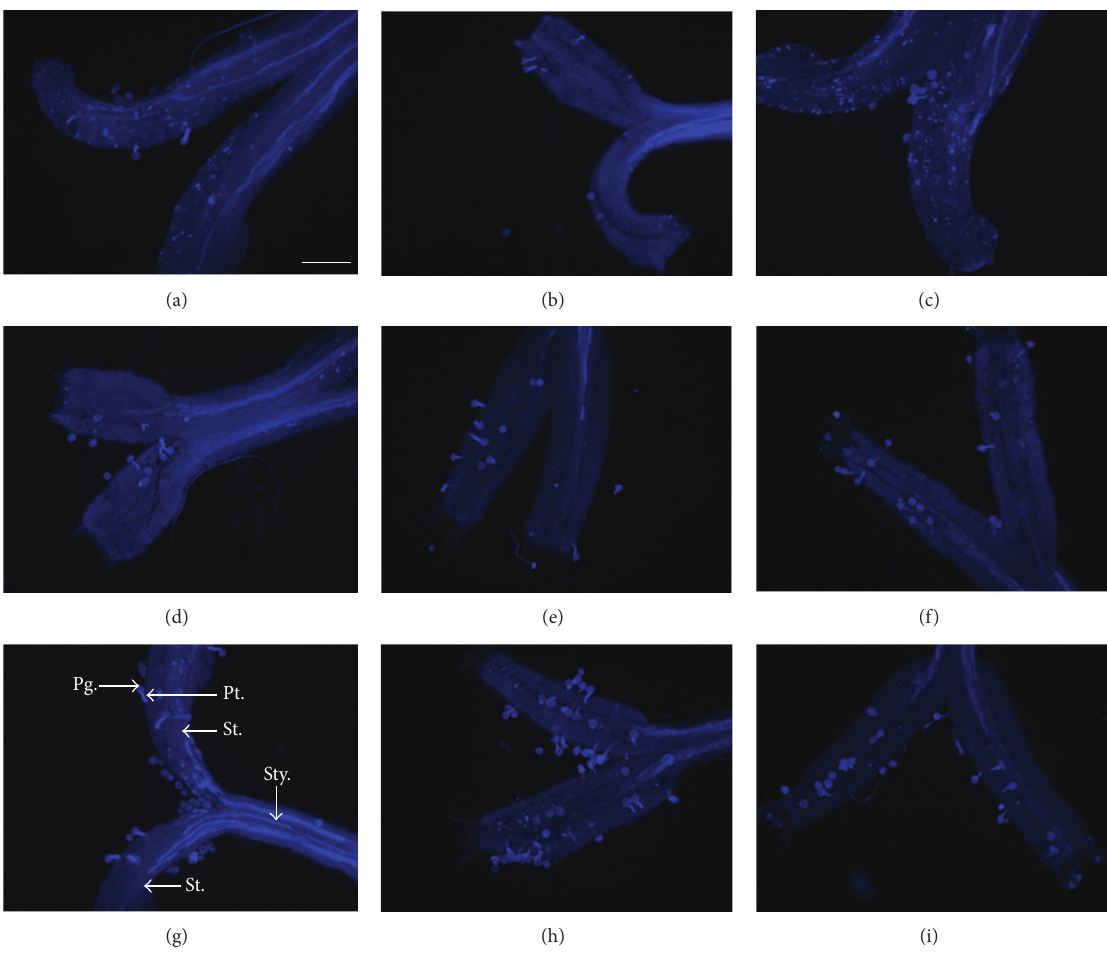
Figure 1: Germination behaviour of pollen grains on chrysanthemum stigmas at 24 hours after self-pollination. ((a), (b), and (c)) Three representativecultivars(“QX-081,”“Nannonghonghe,”“QX-0062f-3,”and“Nannongxiangbin”)withlownumberofpollengrainsgerminating onperstigma.((d),(e),and(f))Threerepresentativecultivars(“Nannongxiangbin”,“Q10-6-9,”and“Q10-17-3”)withmediumnumberofpollen grains germinating on per stigma. ((g), (h), and (i)). Three representative cultivars (“QX-097,” “Q10-33-1,” and “QX-149”) with high number of pollen grains germinating on per stigma. Abbreviations: Pg.: pollen grain, Pt.: pollen tube, St.: stigma, and Sty.: style. All the figures have the same bar (100 𝜇